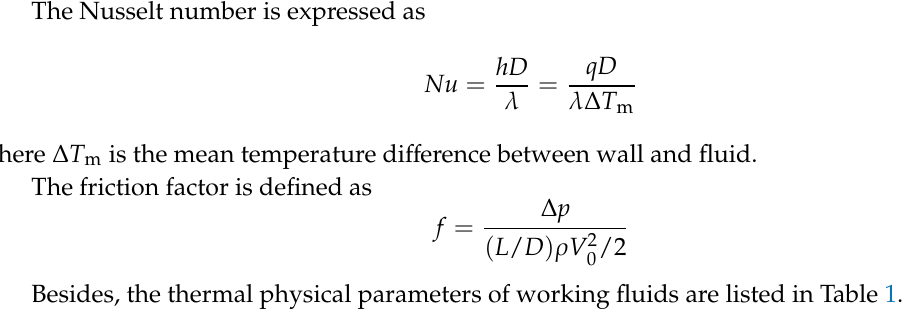
Table 1. Thermal physical parameters of working